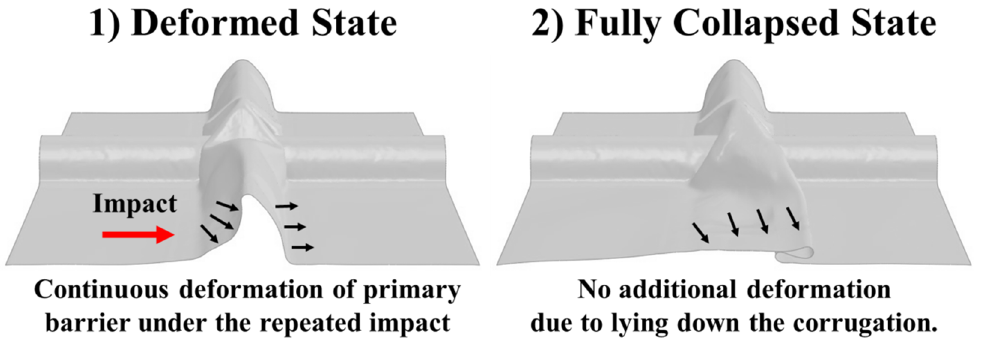
Figure 13. Collapse phase of corrugation under the repeated impact loading.